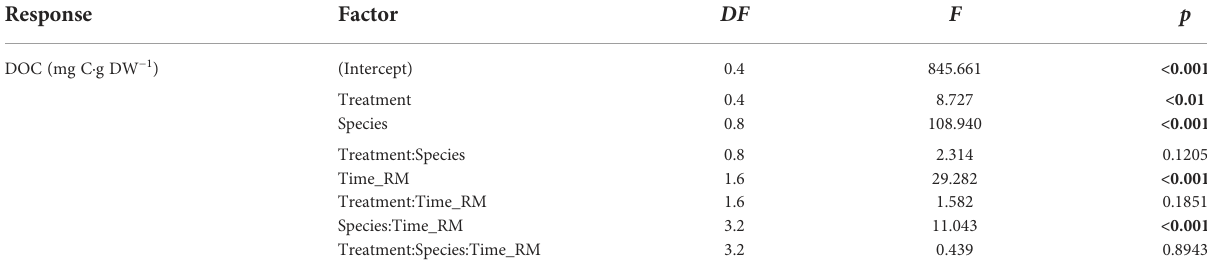
TABLE 1 Repeated measures analysis of variance (ANOVA) of the DOC release experiment.